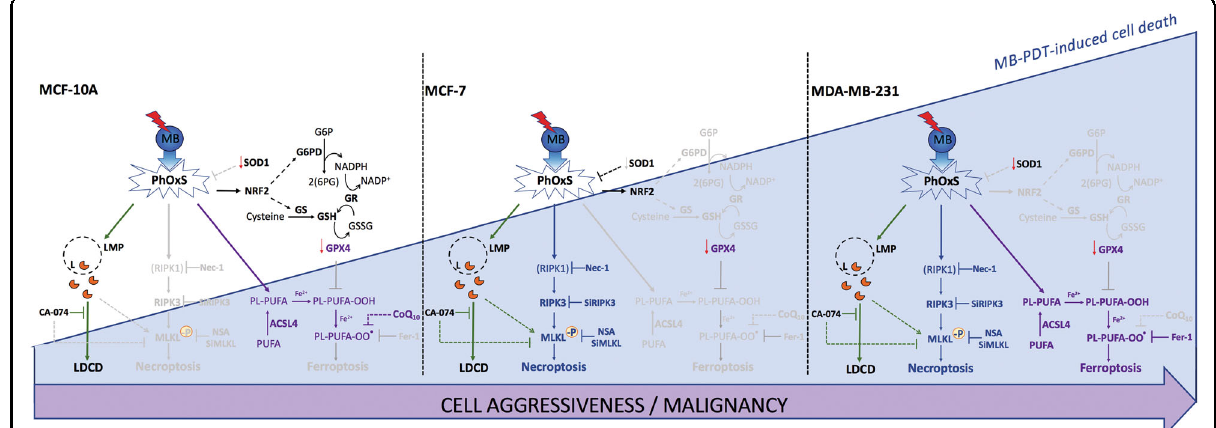
Fig. 6 Scheme summarizing the antioxidant and cell death mechanisms activated in human breast cells by MB-PDT. Breast cells display different susceptibility to photo-oxidative stress (PhOxS) induced by MB-PDT, being the highest effect observed in MDA-MB-231. In this cell line, no antioxidant response was mounted upon PhOxS. In addition, low levels of GPX4 and CoQ 10 , combined with high amount of iron (Fe 2 + ) and PUFA- phospholipid content (PL-PUFA), resulted in ferroptosis activation by MB-PDT (purple arrows and letters). This cell death was inhibited by Fer-1 pretreatment. Lysosomal damage was observed in all cell lines, evidenced by the release of cathepsin B through lysosomal membrane permeabilization (LMP) (green arrows and letters). Pretreatment with CA-074, a cathepsin B inhibitor, alleviated cell death. In both tumorigenic cells, MDA-MB-231 and MCF-7, necroptosis activation with MLKL plasma membrane pore formation (blue arrows and letters) was observed. Inhibition of RIPK1, RIPK3, or MLKL phosphorylation, by gene silencing or pretreatment with Nec-1 or NSA, rescue tumorigenic cells from death. A possible link between LMP and necroptosis was found in tumorigenic cells (green dotted arrows). As MCF-7 cells lack signi fi cant amounts of oxidizable phospholipids, lipid peroxidation was not observed and, therefore, ferroptosis did not contribute to death. However, a complete antioxidant response was not sustained in these cells, making them also highly affected by MB-PDT. The scenario after PhOxS was quite different for MCF-10A cells. Even undergoing LMP and lipid peroxidation, they were signi fi cantly more resistant to MB-PDT than the other cells. Neither ferroptosis nor MLKL phosphorylation nor necroptosis were